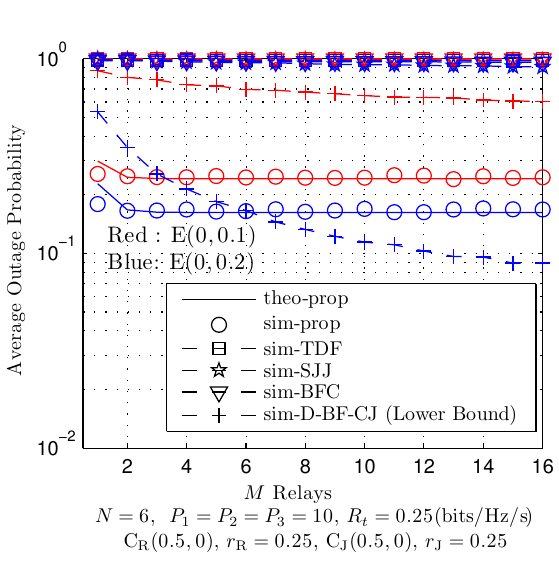
Figure 3. Outage probability in relation to changes in the number of relays with N = 6 .